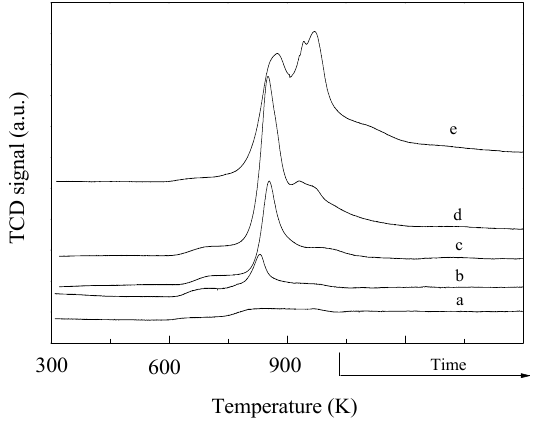
Figure 3. H 2 ‐ temperature programmed reduction (H 2 ‐ TPR) profiles of MSU ‐ 1 and VO x /MSU ‐ 1 with different VO x loading. ( a ) MSU ‐ 1; ( b ) 2.5 wt. % VO x /MSU ‐ 1; ( c ) 7.0 wt. % VO x /MSU ‐ 1; ( d ) 12.0 wt. % VO x /MSU ‐ 1; and ( e ) 17.5 wt. % VO x /MSU ‐ 1.